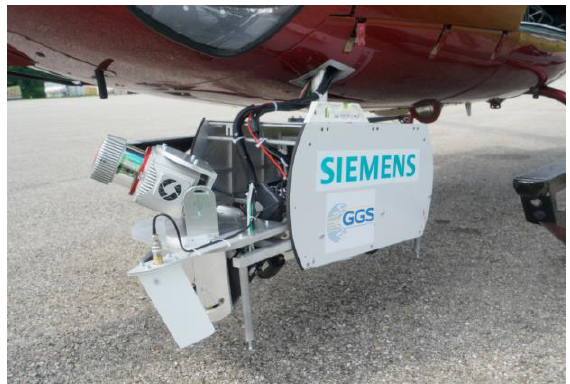
Figure 4: Monitoring system with 14 sensors for powerline monitoring, adaptable also for disaster mapping (Kemper 2018.)